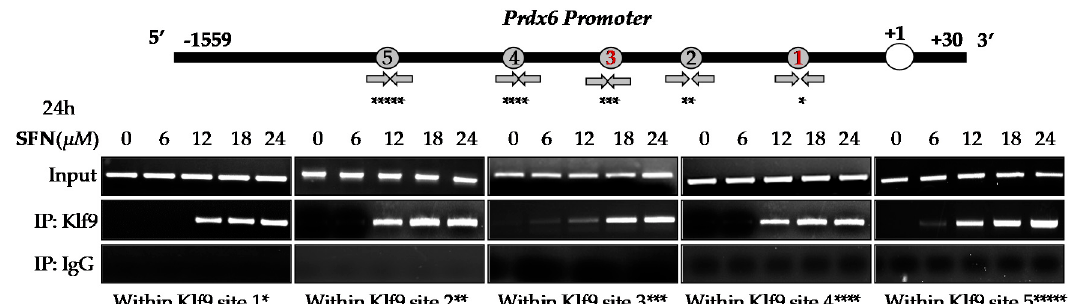
Figure 6. Higher doses of SFN enforced Klf9 binding to the regulatory region of its new target gene, Prdx6 . Top panel; diagrammatic illustration of in silico analysis of Prdx6 gene promoter showing five putative repressive Klf9 binding elements (RKBE; nC A / G CCCn). hLECs treated with DMSO or di ff erent concentration of SFN for 24 h, as indicated. Pulled DNA fragments with antibodies specific to Klf9 were subjected to PCR analysis for repressive Klf9 binding elements (RKBE) as described in Materials and Methods. DNA fragments present in the immunoprecipitates were amplified with primers that recognized a fragment of Prdx6 promoter containing RKBE as indicated. Control IgG served as negative control. Primers used for amplification of specific region containing Klf9 sites (* Klf9 site 1, ** Klf9 site 2, *** Klf9 site 3, **** Klf9 site 4, ***** Klf9 site 5). Primer sequences were mentioned in the